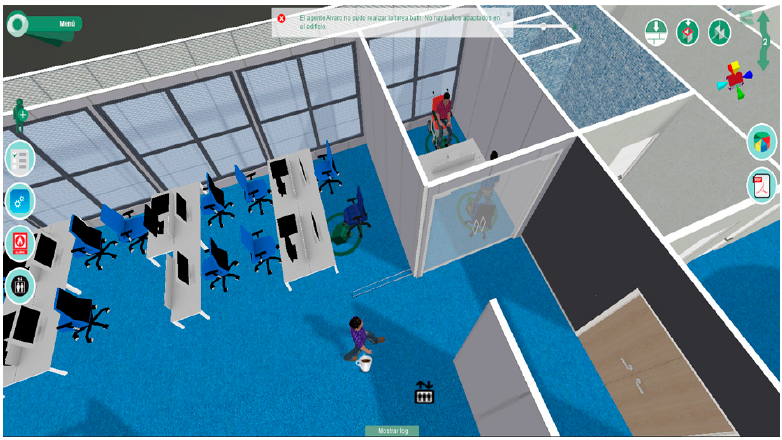
Figure 10. Simulation tool.